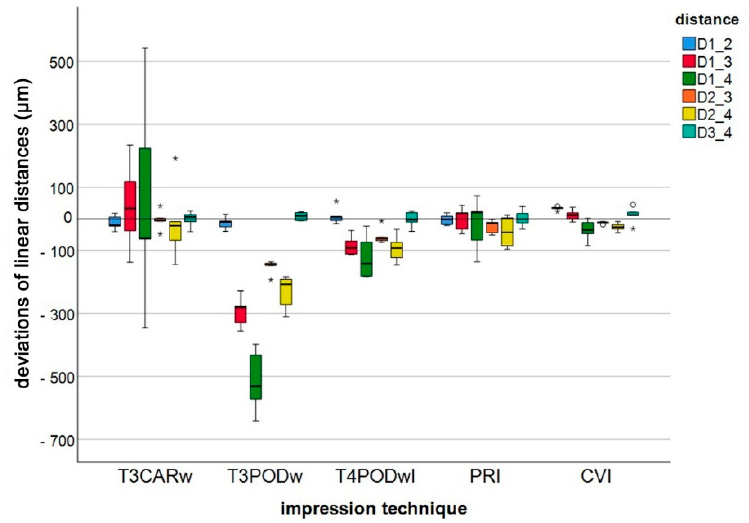
Figure 3. Boxplot diagram of the deviations of linear distances (D1_2, D1_3, D1_4, D2_3, D2_4, D3_4) measured between the centers of the four spheres (1–4) for the different impression techniques (Trios 3 Cart wired (T3CARw), Trios 3 Pod wired (T3PODw), Trios 4 Pod wireless (T4PODwl), Primescan (PRI), conventional impression (CVI); outliers ( ○ ), extreme values (*)).